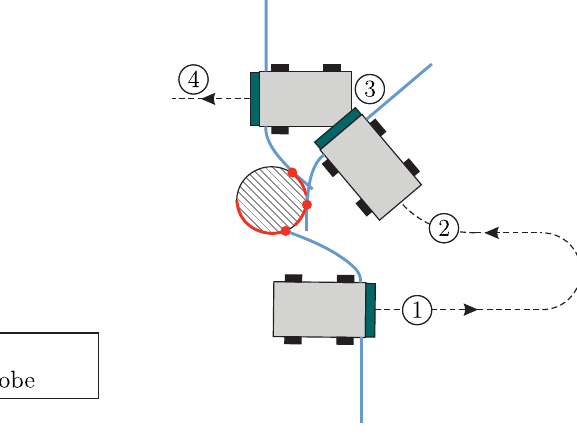
Figure 1. Mobile robots equipped with tactile sensors exploring using different probes to explore their environments: ( a ) robot with a dual switch or a skin-like sensor with limited range—(1) robot passing the object without sensor contact, (2) first collision with the object leads to the detection of a single discrete point, (3) moving backwards/ repositioning, (4) second collision with the object leads to the detection of a second discrete point, (5) see (3), (6) obstacle avoidance completed; ( b ) robot with a rod-shaped, highly flexible sensor—(1) passing the object witch continuous sensor contact (detecting a sequence of contact points), (2) using information from (1) for making the next contact, (3) wall-following from (2) to (3) by keeping the signals constant, (4) obstacle avoidance